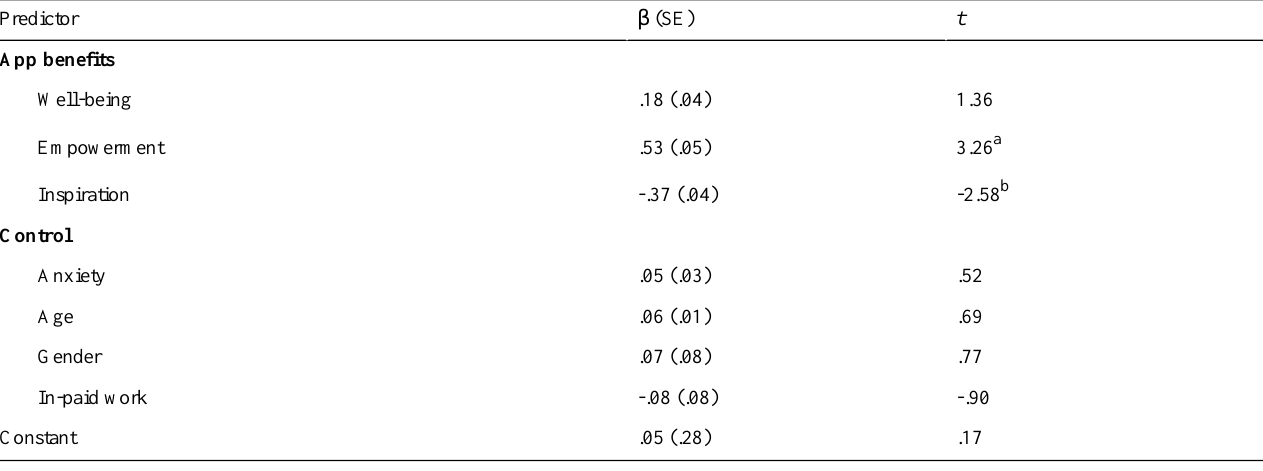
Table 5. Reduction in number of cigarettes smoked for remaining smokers (R 2 =.21, F 7, 113 =4.28, P